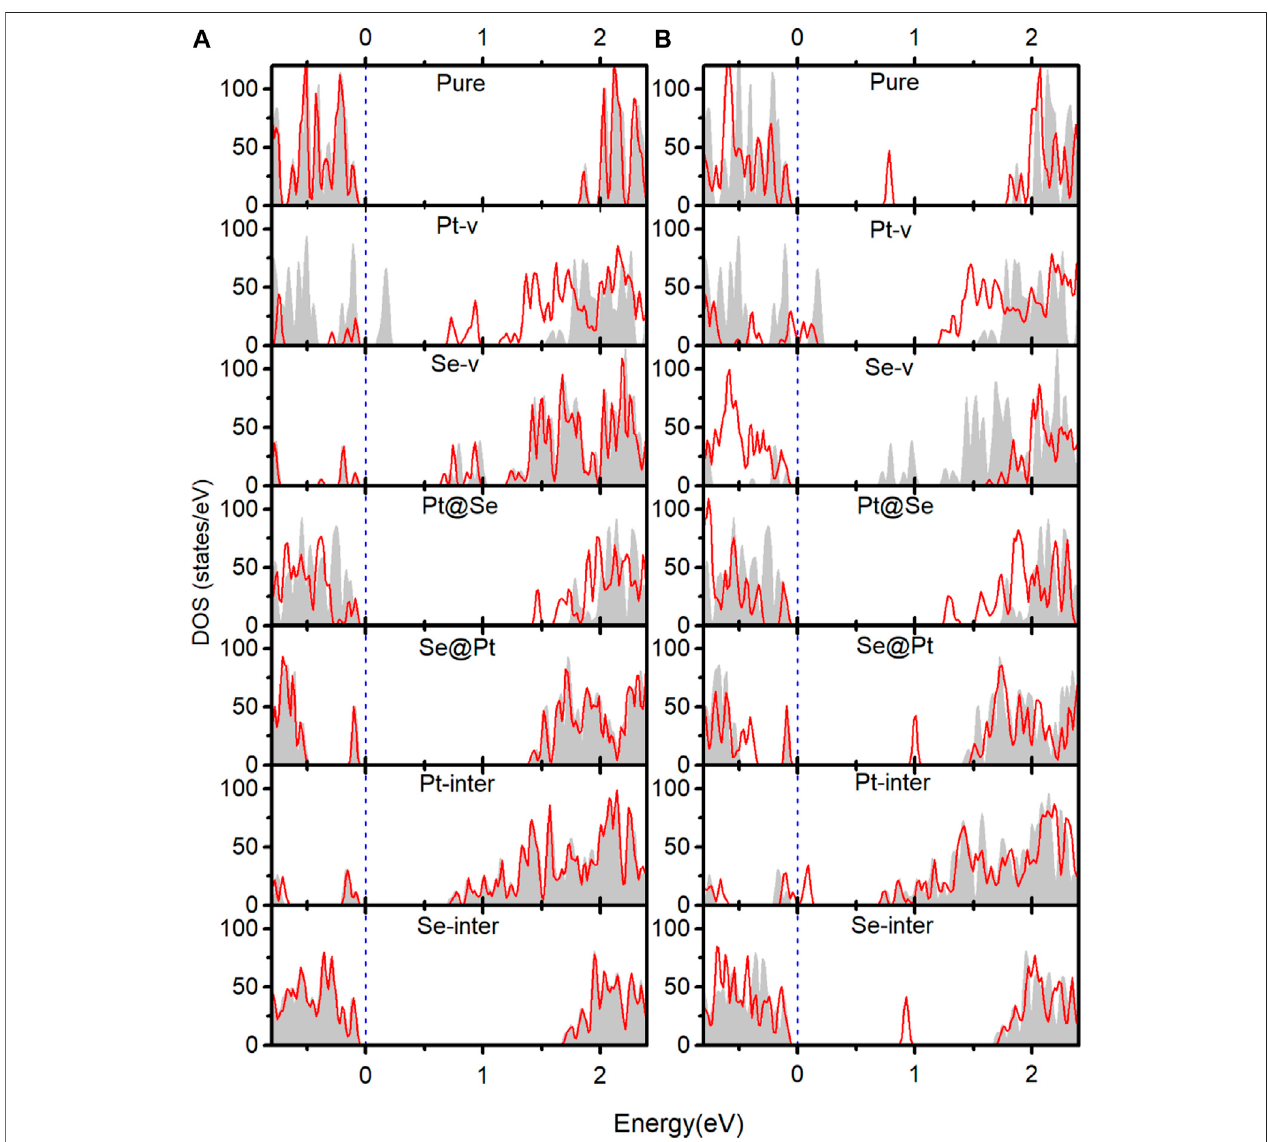
FIGURE4| Redlines indicate theDOSneartheband edgesofpureand defected PtSe 2 with theadsorption ofN 2 (A) and O 2 (B) . Thegray areas indicate the DOS near band edges of pure and defected PtSe 2 .